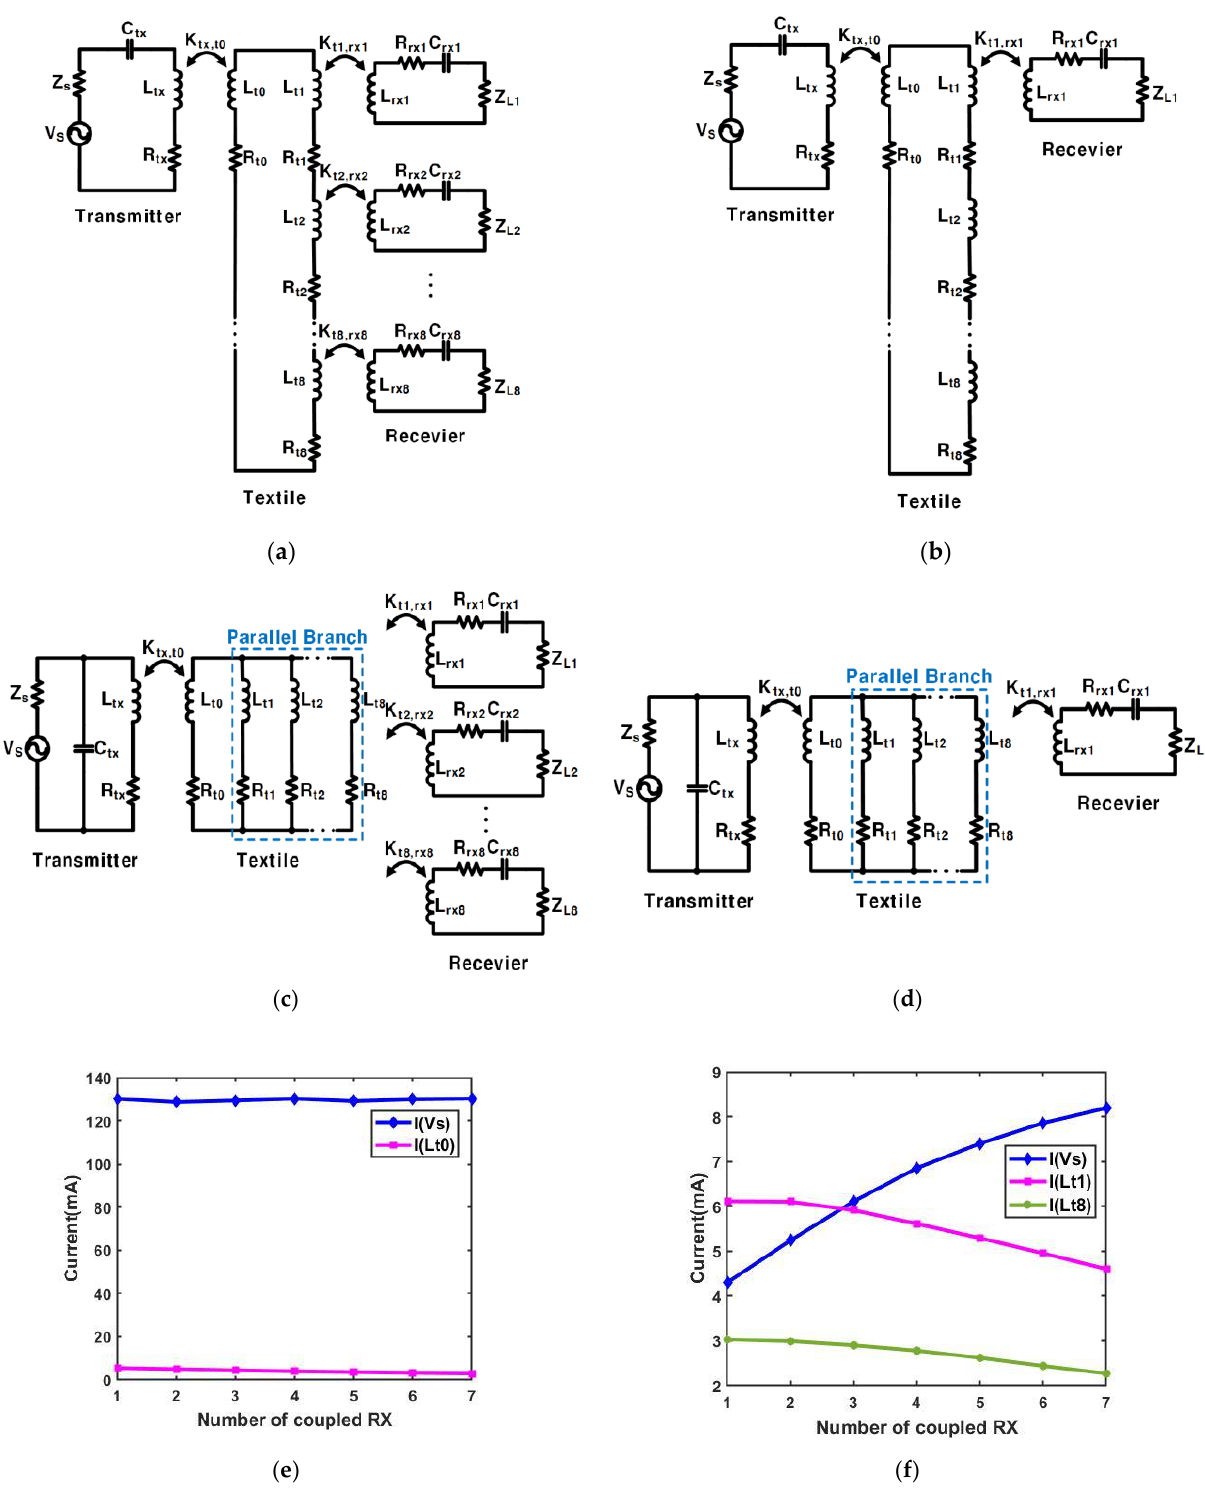
Figure 2. ( a ) Series circuit for the textile with 8 RXs coupled; ( b ) Series circuit for the textile with 1 RX coupled; ( c ) Parallel circuit for the textile with 8 RXs coupled; ( d ) Parallel circuit for the textile with 1 RX coupled; ( e ) The current of V s and the current of the textile coil L t 0 in the series current when the number of coupled RXs is n ( n is 1 to 8); ( f ) The current of V s , the current of the textile coil L t 1 , and the current of the textile coil L t 8 in the parallel circuit when the number of coupled RXs is n ( n ranges from 1 to 8).